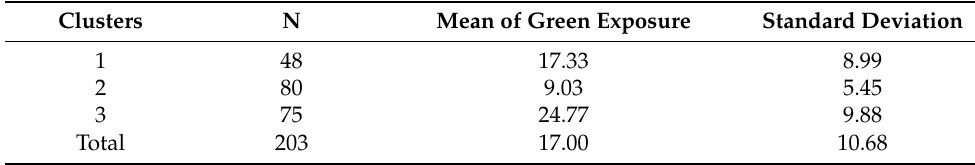
Table 6. Mean value of green exposure in different clusters (three